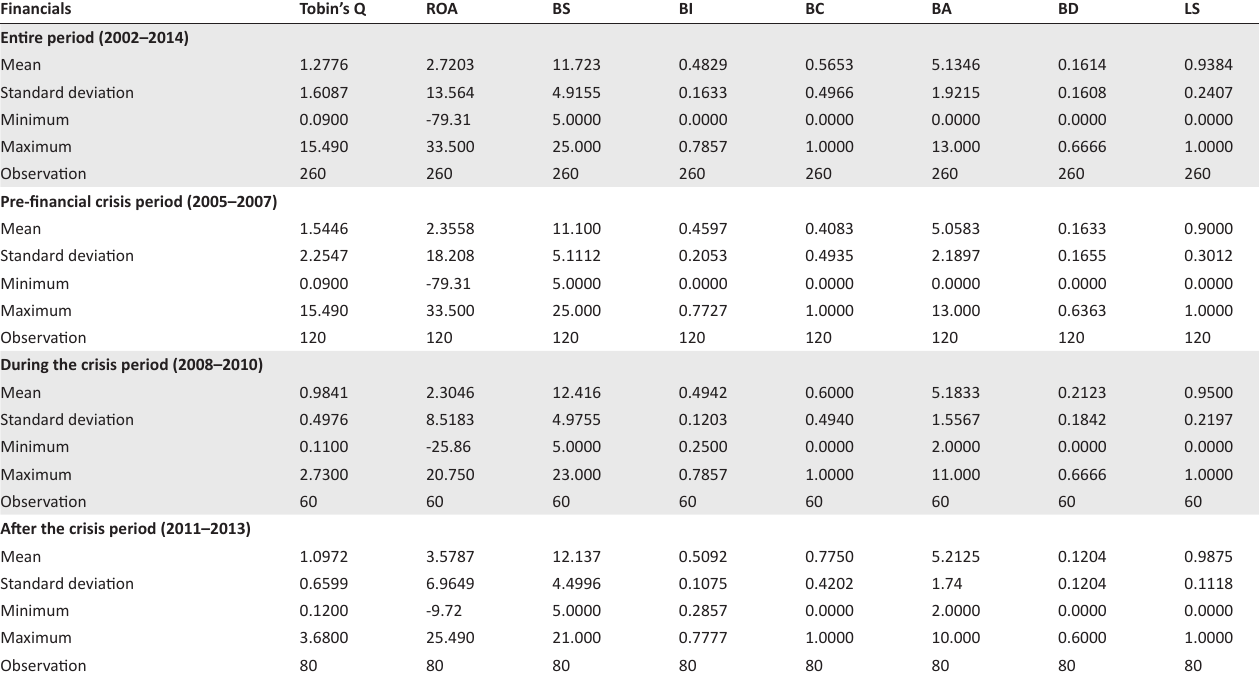
Table 1-A2: Descriptive statistics for the financials industry.